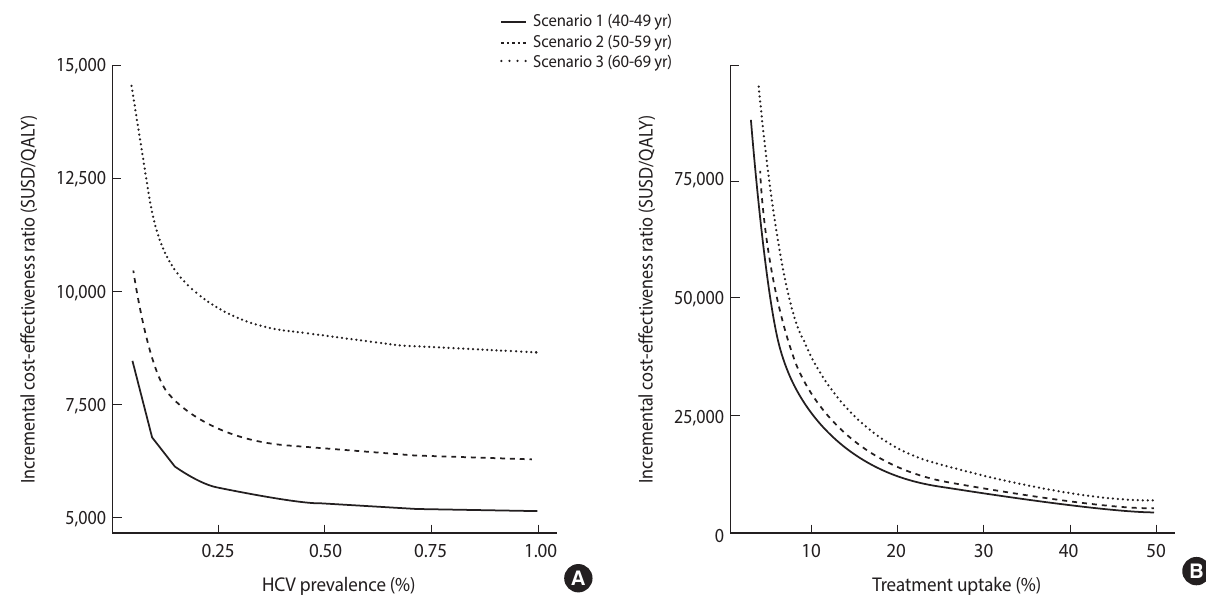
Figure 3. The cost-effectiveness analysis of anti-HCV screening for Korean population in their 5th, 6th, and 7th decade, respectively, with various prevalence (A) and treatment rates (B) [10]. QALY, quality adjusted life